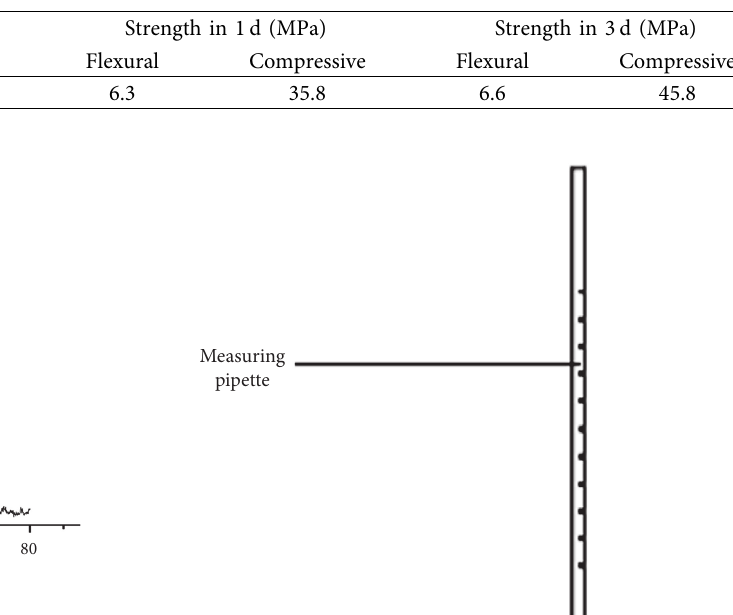
Table 2: Properties of CSA.